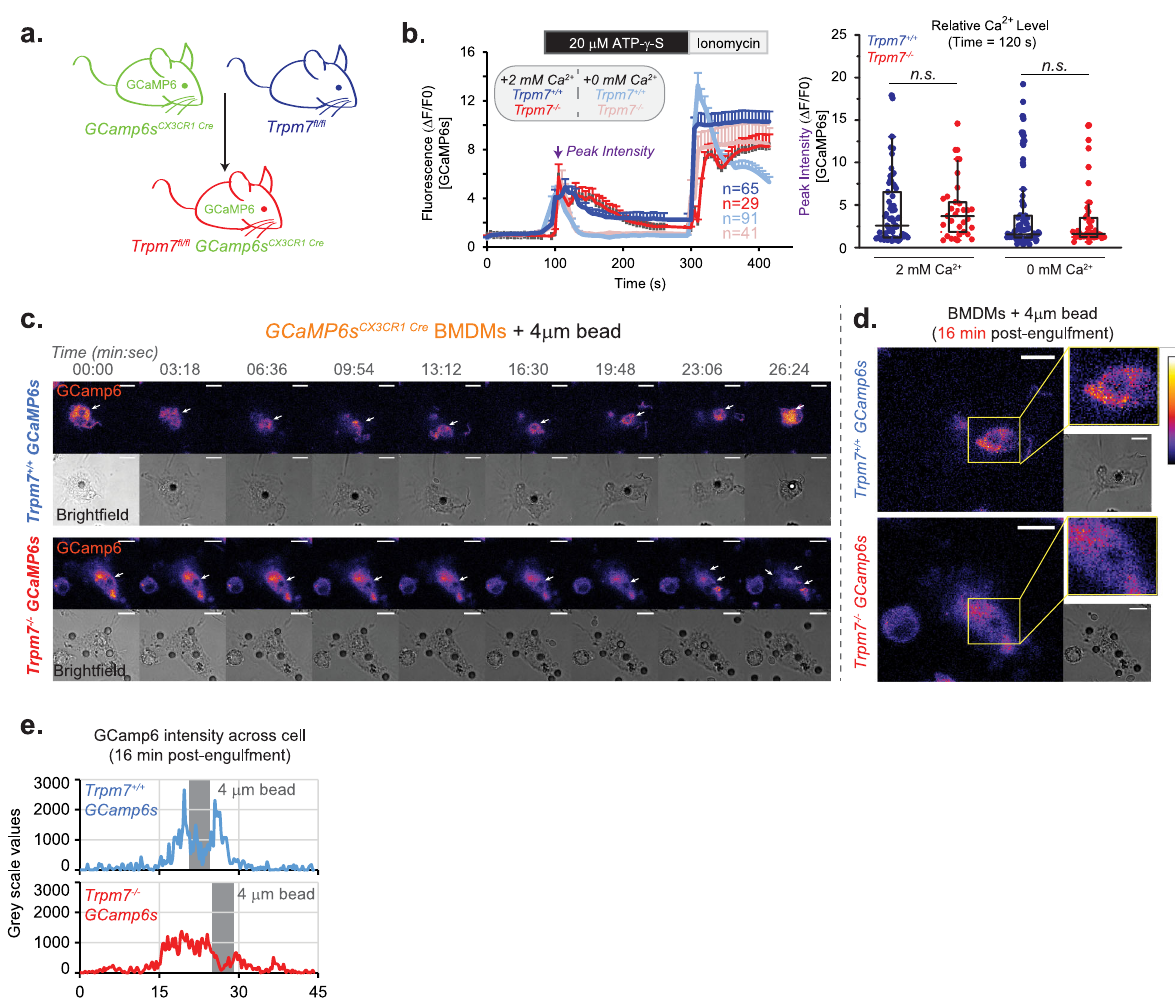
Fig. 8 Phagocytosis of apoptotic cells triggers phagosome-proximal elevations in Ca 2 + . a Generation of TRPM7 WT and KO GCaMP6s-expressing mouse strains is schematized. b Relative changes in [Ca 2 + ]i, as depicted by GCaMP6s- fl uorescence, in response to ATP over time in GCaMP6s-expressing BMDMs. Cells were treated with 20 μ M ATP- γ -S for 3 min in bath solution containing either 0 or 2 mM Ca 2 + , as indicated. Ionomycin (2 μ M) was added as a positive control. Left: Mean GCaMP6s intensity over time (n values shown in the fi gure); error bars represent SEM. Right: Quanti fi cation of peak GCaMP6s- fl uorescence intensities after ATP- γ -S addition, at the timepoint indicated by an arrow in the left panel; Each data point in the box chart re fl ects a cell. The mean value is depicted by a solid horizontal line across the box. c Changes in [Ca 2 + ] i during phagocytosis in GCaMP6s-expressing WT (top) and KO BMDMs (bottom) during phagocytosis of 4 μ m carboxylated beads. Arrow indicates bead-containing phagosome. GCaMP6s- fl uorescence (top image; Fire LUT) and bright fi eld (bottom image; gray) were acquired via confocal microscopy and single optical section (0.5 μ m) is shown. Scale bar is 10 μ m. d Periphagosomal [Ca 2 + ] i in WT and KO BMDMs is shown as a magni fi ed image from panel a , 16 min post-engulfment. GCaMP6s- fl uorescence ( fi re) and bright fi eld (gray) are shown with ROI highlighted (yellow box). Relative scale of GCaMP6s intensity is show on the right. Scale bar is 10 μ m. e Measurement of [Ca 2 + ] i derived from a line scan analysis from cells depicted in panel b . Fluorescent intensity of GCaMP6s was measured across the length of the cell through the indicated phagosome in a single x – y plane line trace. Bead location indicated by gray column. Source data are provided as a Source Data fi le, and statistical testing is described in “ Statistics and Reproducibility ” (extracellular), both WT and KO GCaMP6s BMDMs responded rapidly to 20 μ M ATP- γ -S, a non-hydrolyzable analog of ATP, with a fi ve-fold increase in mean GCaMP6s- fl uorescence relative to baseline Ca 2 + levels (Fig. 8b). ATP-triggered Ca 2 + elevations decayed slowly, likely due to SOCE, and cytosolic Ca 2 + concentration [Ca 2 + ] i decayed toward resting levels (baseline) after nearly 220 s. Finally, the addition of ionomycin elicited the maximal Ca 2 + response. In 0 mM extracellular Ca 2 + , the release of intracellular stored Ca 2 + from the ER was comparable in amplitude to the SOCE seen in 2 mM Ca 2 + , but unsurprisingly, [Ca 2 + ] i decayed to baseline in only 45 seconds.